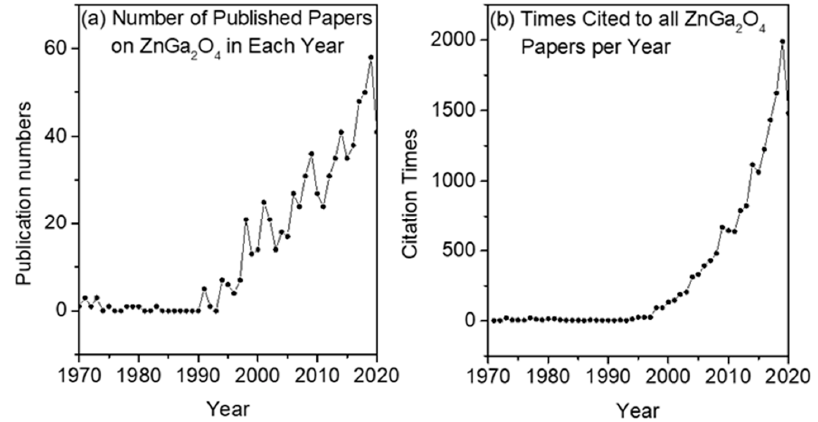
Figure 1. Statistic line graph about ZnGa 2 O 4 publications ( a ) Number of publications from 1970 to 2020 / 10 / 22. The total number of the publications is 732. ( b ) Citation times to all ZnGa 2 O 4 papers from 1971 to 2020 / 10 / 22. The total number of citations is 16,567.